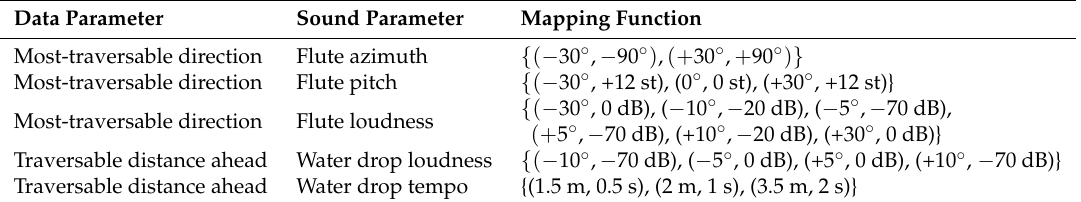
Figure 5. Path sonification. ( a ) Traversable distance curves, where green masks represent detected ground, and the blue curve and red curve represent respectively the raw traversable distance curve and the smoothed curve. The red arrow denotes the most-traversable direction. ( b ) According to the most-traversable direction, either flute sound or water drop sound will be played. Table 3. Parameter mapping rules of path sonification. Pathway information is mapped to the parameters of flute and water drop